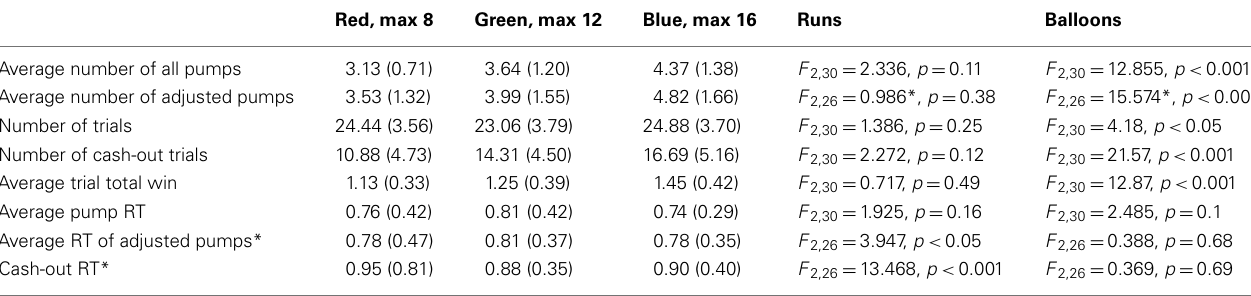
Table 1 | Statistical analyses of behavioral variables from the task (SD in